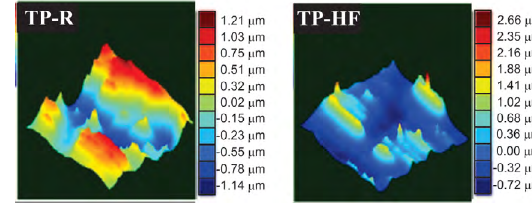
Figure 3. Cross section analyzed by SEM / EDS tinplate as received.